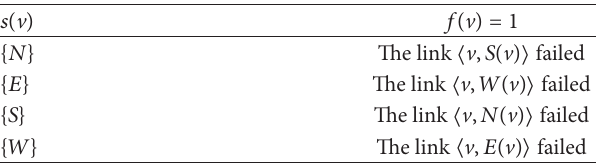
Table 1: Given a node V with 𝑓( V ) = 1 , judging its 𝑠( V ) according to its incident failed